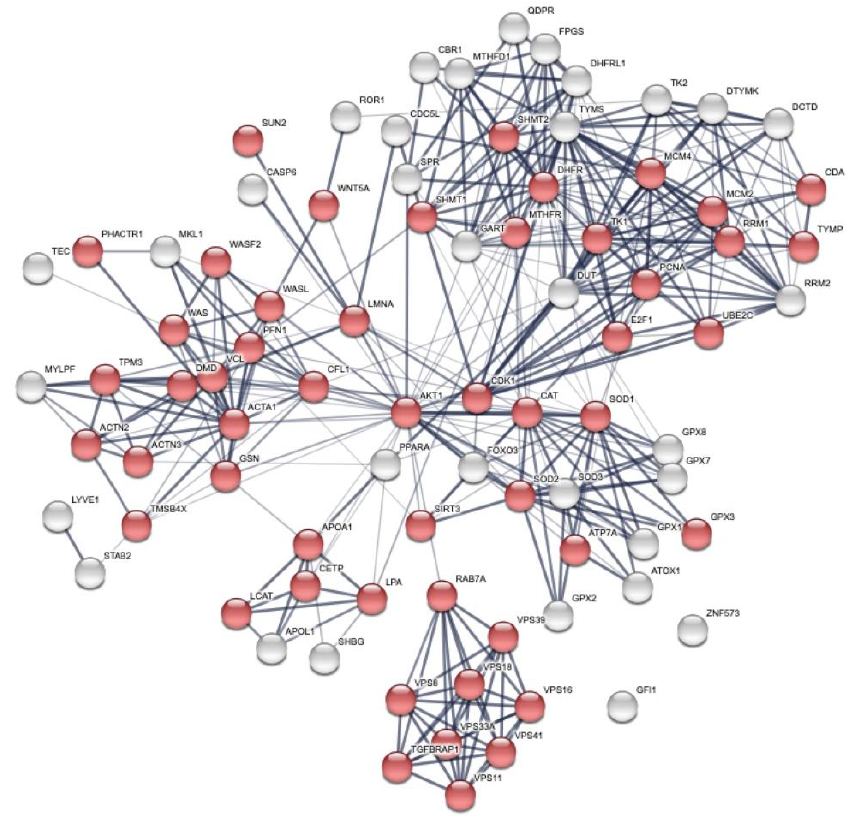
Figure 3. Global network visualization based on STRING pathway enrichment analysis of the 12 DEP proteins + TYMS and DHFR showing the most extended biological process containing the protein panel. Details are reported in the main text. Red spheres represent the cellular metabolism organization biological process with the following STRING features: GO:0016043 and FDR 51/5163.